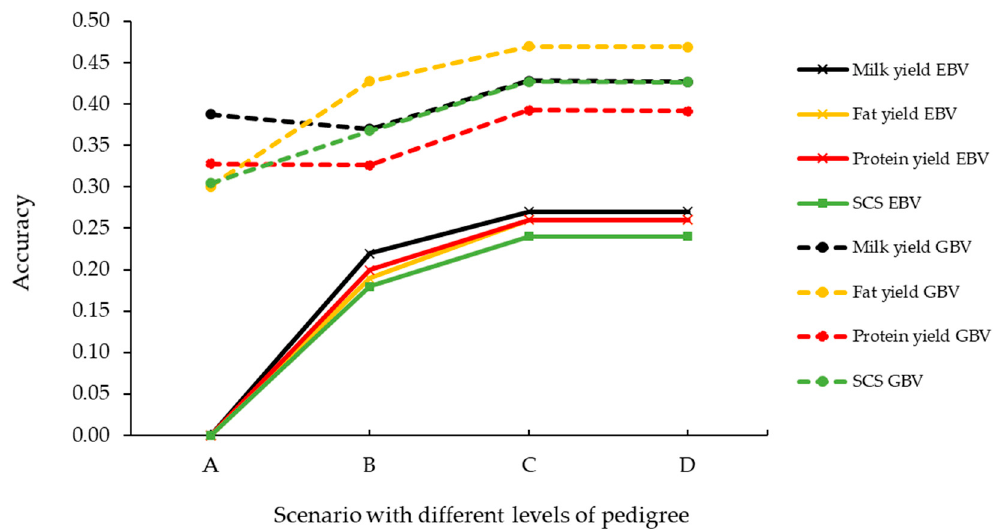
Figure 1. Average prediction accuracies of the across-breed breeding values (EBVs) and genomic breeding values (GBVs) of milk traits obtained using the pedigree-based best linear unbiased prediction (PBLUP) and single-step BayesC (ssBC) models, respectively, for validation animals. Animals in scenarios A, B, and C were obtained from the same evaluations, and the accuracies were summarized for animals when both the sire and dam was recorded (Scenario A, n = 161 animals), the sire was recorded and had ≥ 5 progeny in the herd (Scenario B, n = 155 animals), and the dam was recorded and had ≥ 1 lactation record (Scenario C, n = 6 animals). Animals in scenario D were obtained from a second evaluation where the pedigree records of animals that previously had records of both the sire and dam were masked (n = 162 animals).